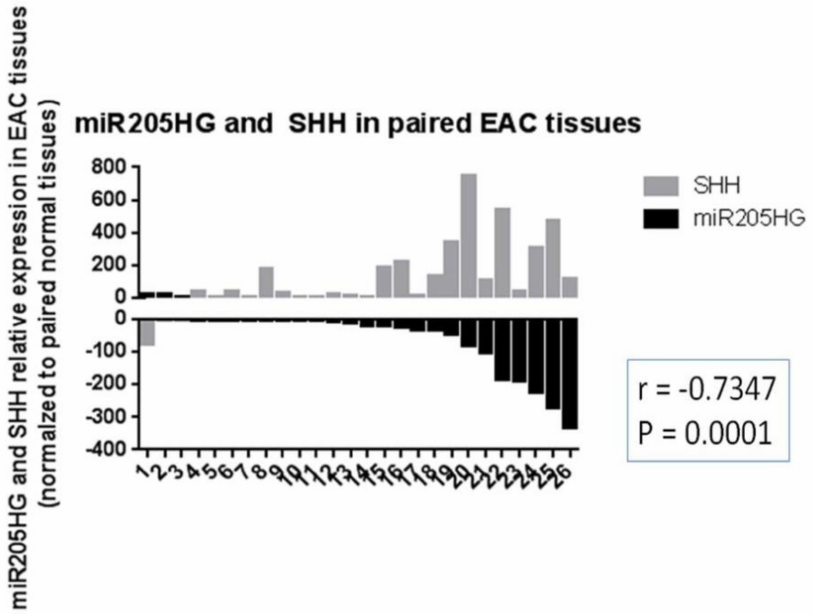
Figure 15. Upregulation of SHH and inverse correlation between miR205HG and SHH levels in EAC tissues. Tissues from 26 EAC patients that had already been tested for miR205HG expression were also tested for SHH expression by qRT-PCR. SHH expression was significantly upregulated relative to NE in the majority of EACs studied (23/26, average fold-change 154.7, paired t -test p -value < 0.0001). In addition, miR205HG and SHH expression levels were significantly inversely correlated (r = − 0.73, p -value = 0.0001).